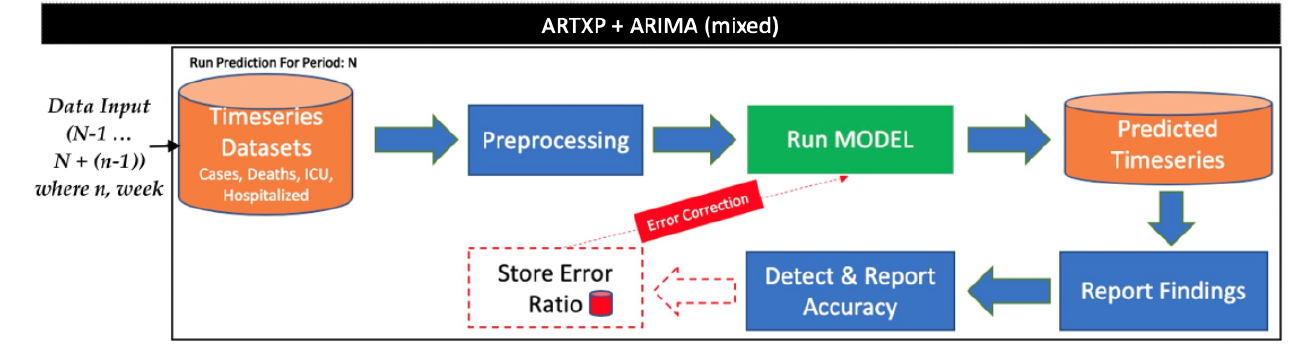
Figure 4. ARTXP and ARIMA